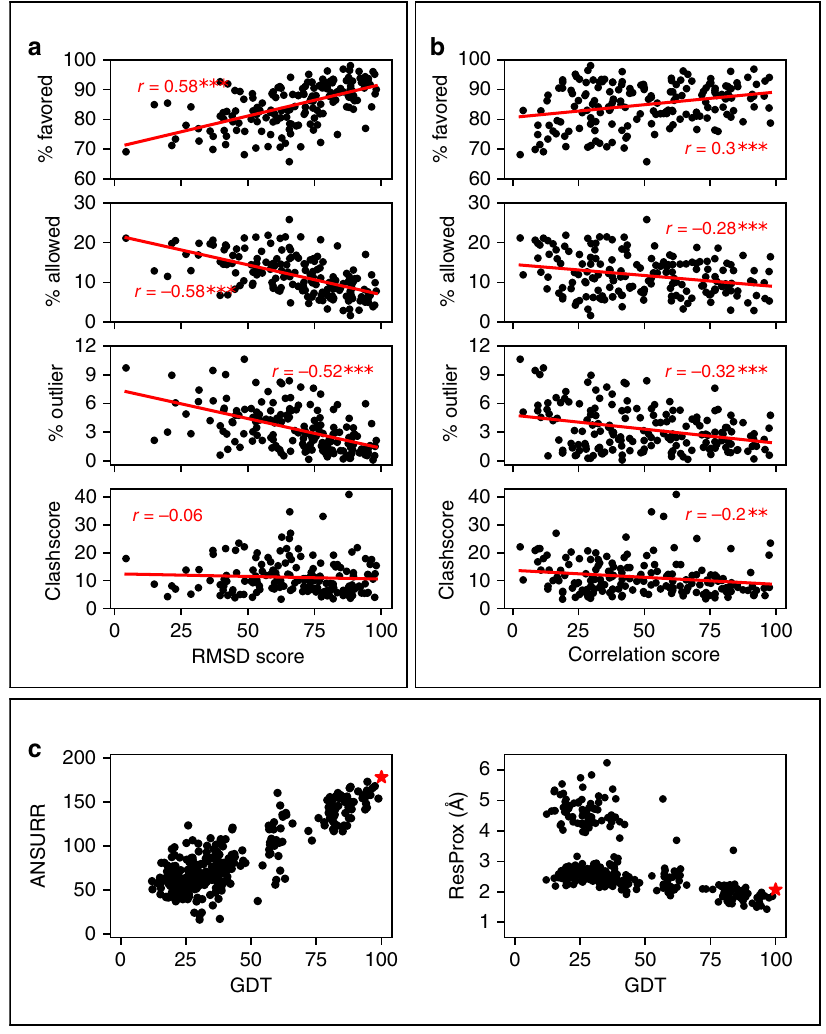
Fig. 5 Performance of ANSURR against geometry-based measures. The top part shows correlations between geometry-based measures and a RMSD score, b correlation score. The statistical signi fi cance of the correlation coef fi cient is indicated by *** p < 0.001, ** p < 0.01, and * p < 0.05, determined using a two-tailed Pearson test. p values are (top to bottom) a 1 × 10 − 16 , 4 × 10 − 17 , 2 × 10 − 13 , 0.44 b 8 × 10 − 5 , 2 × 10 − 4 , 2 × 10 − 5 , 8 × 10 − 3 . c Comparison of ANSURR to ResProx, using 300 decoys generated by 3DRobot for the test PDB fi le 1cfc. The horizontal axis is the Global Distance Test, a measure of similarity to the test structure (see Fig. 3), which is indicated by the red asterisk. The left box assesses the decoys using ANSURR, where for simplicity we have combined the RMSD score and correlation score into a single sum. There are no decoys with better ANSURR score than the test structure. The right box assesses the same set of decoys using ResProx. There are 57 decoys with better (i.e., lower) ResProx values than the test structure. See Supplementary Fig. 2 for more